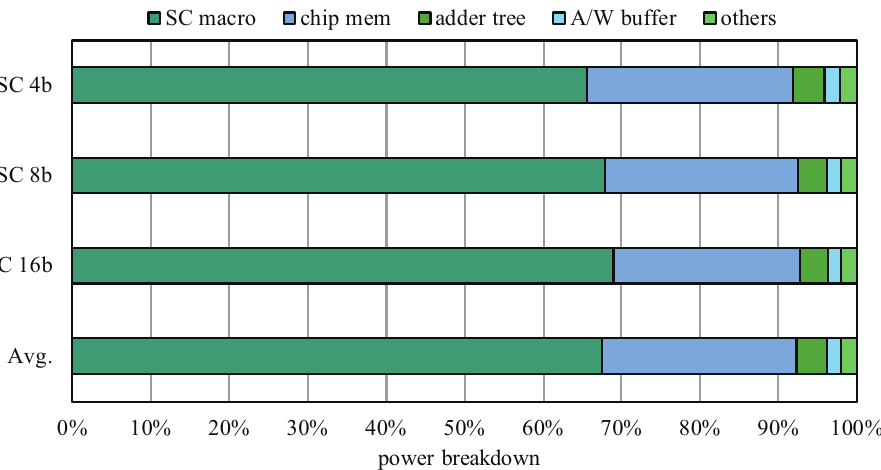
Figure 13. Power breakdown for different computational bit widths.